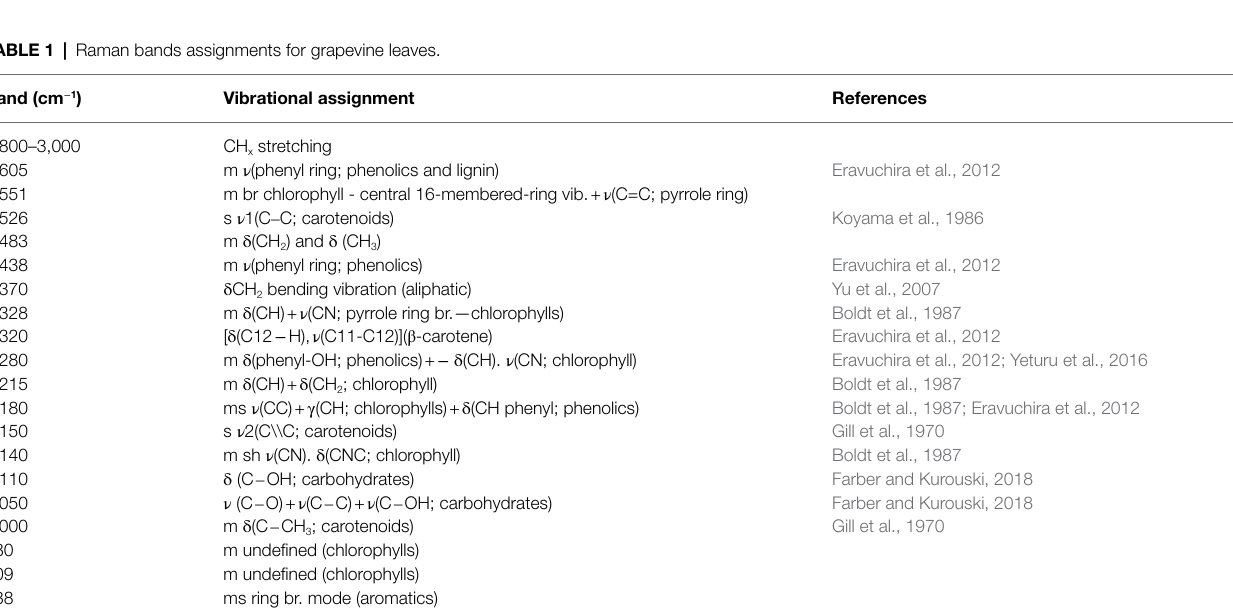
( Supplementary Figure S1 ) for a better comparison. For the